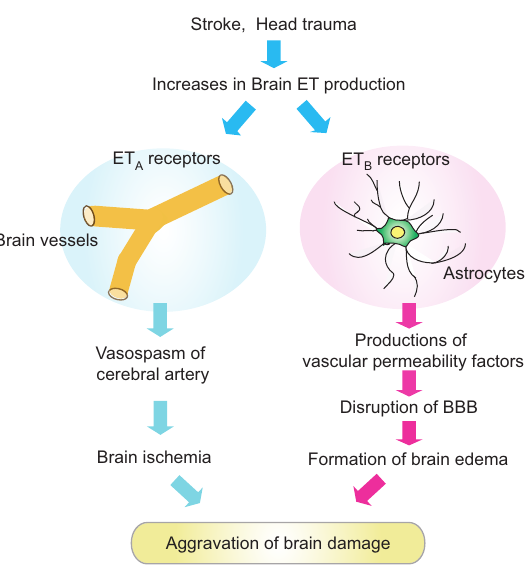
Figure 4 Involvement of ET receptors in vasospasm and brain edema formation after